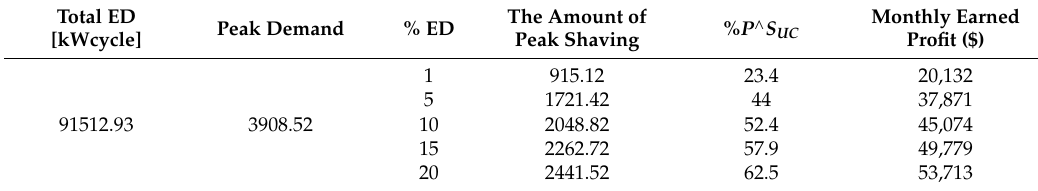
Table 3. Percentage of the peak shaving and monthly earnings based on UC bank for STS crane.